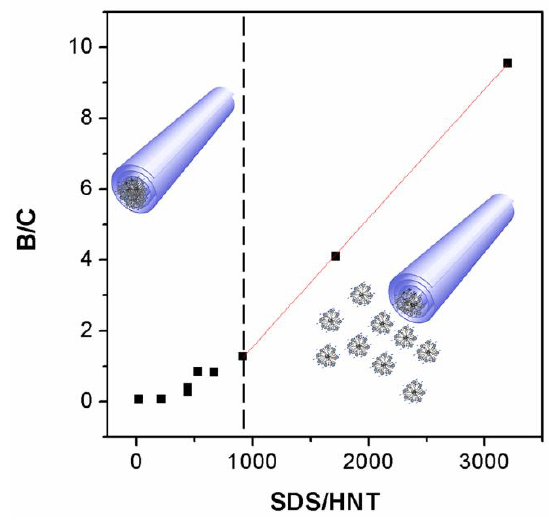
Figure 4. B/C ratio as a function of sodium dodecyl sulphate (SDS)/HNT ratio for the HNT-microemulsion prepared and their schematic representation.